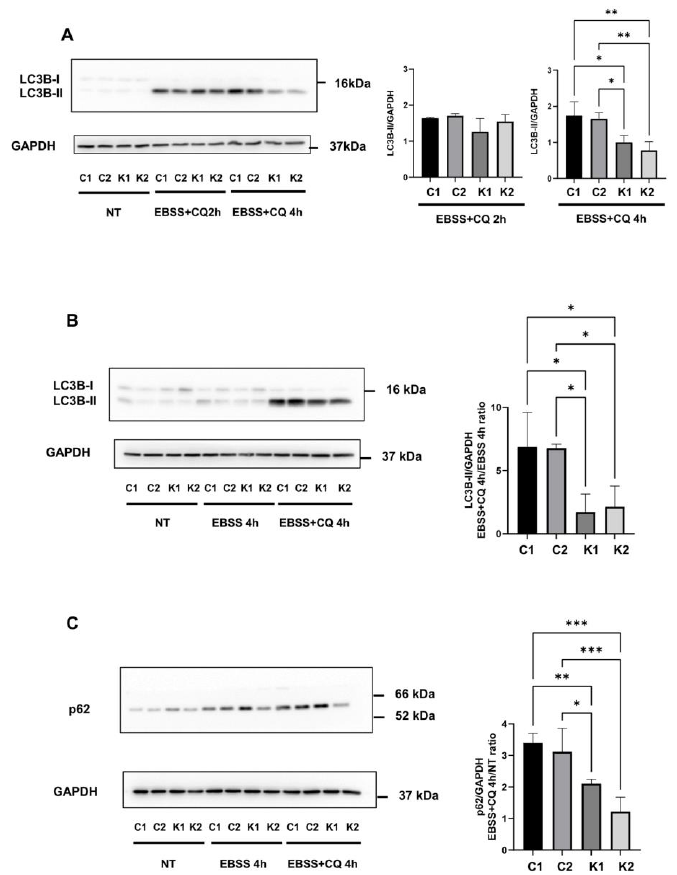
Figure 3. ( A ) Representative Western blotting images of LC3B-I and LC3B-II proteins in growth conditions (NT) and after incubation in EBSS with CQ for 2 h and 4 h and densitometric analysis of LC3B-II accumulation after incubation in EBSS with CQ for 2 h and 4 h. Data are reported as mean ± SD of independent experiments (n = 3). ( B ) Representative Western blotting image of LC3B-I and LC3B-II proteins in growth conditions (NT) and after incubation with EBSS and CQ for 4 h. Densitometric analysis of LC3B-II accumulation is calculated as a ratio between EBSS-CQ 4 h and EBSS 4 h conditions. Data are mean ± SD of independent experiments ( n = 3). ( C ) Representative Western blotting image of p62/SQSTM1 protein in growth conditions (NT) and after incubation with EBSS and CQ for 4 h. Densitometric analysis of p62/ SQSTM1 is calculated as a ratio between EBSS + CQ 4 h and NT. Data are mean ± SD of independent experiments ( n = 4). GAPDH was employed as a loading control. Statistical significance was calculated by one-way ANOVA and Tukey’s multiple comparisons tests *: p < 0.05; **: p < 0.01; ***: p < 0.001. C1: Control 1 fibroblasts; C2: Control 2 fibroblasts; K1: Krabbe 1 fibroblasts; K2: Krabbe 2 fibroblasts. NT: non-treated.